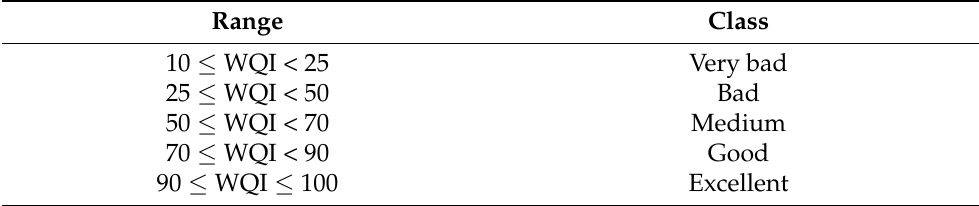
Table 4. WQI evaluation